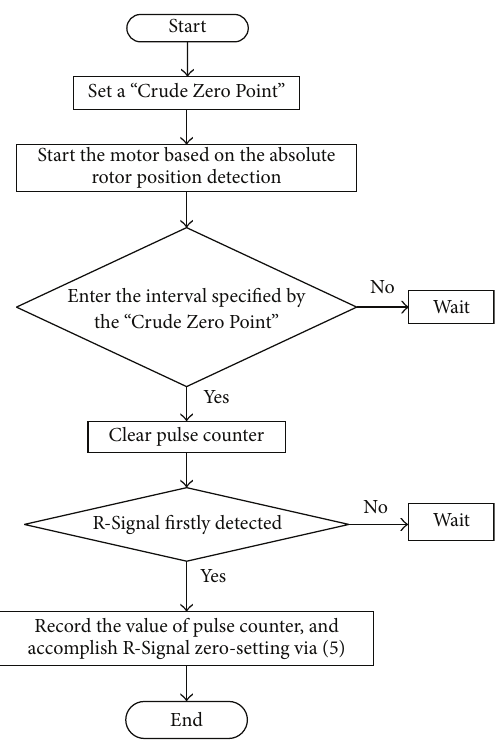
Figure 3: The flow chart of R-Signal zero-setting